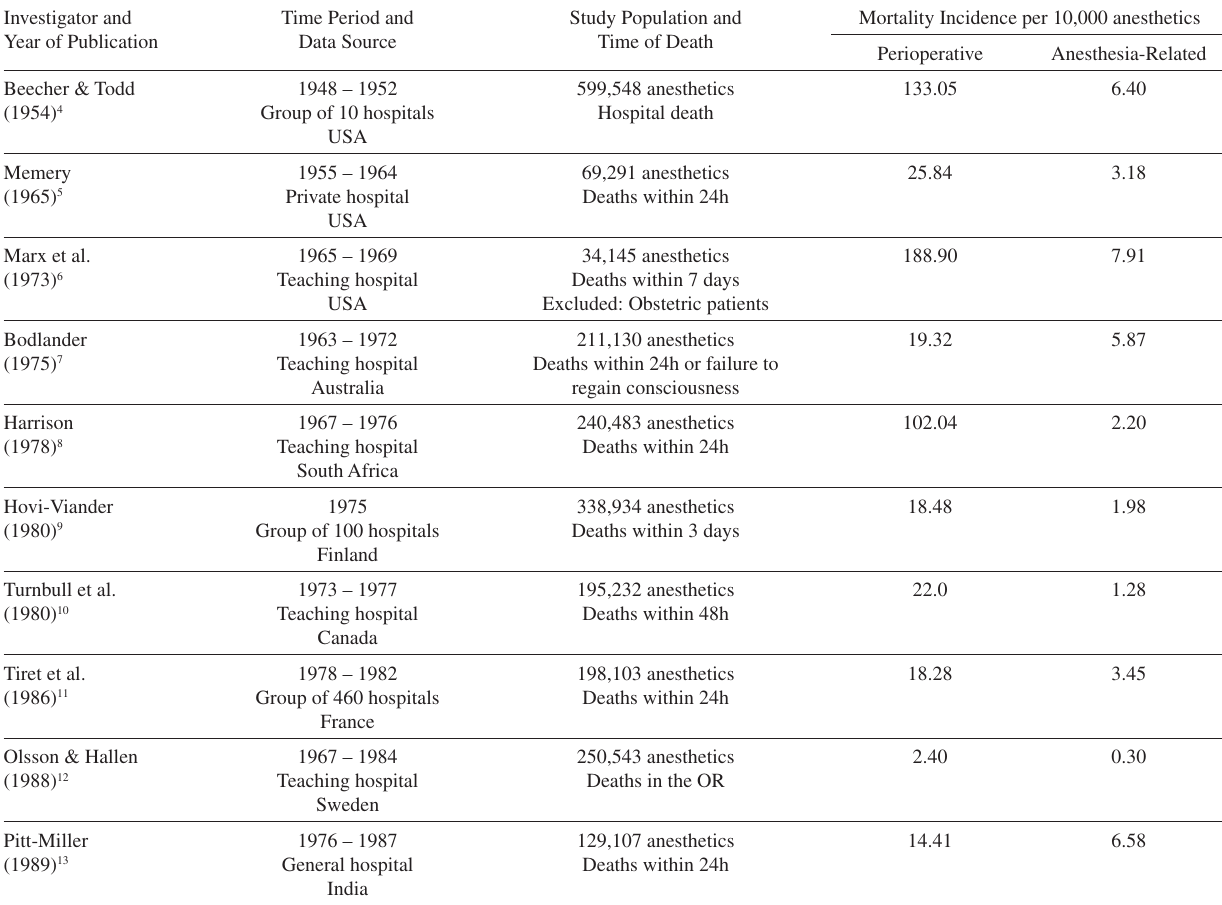
Table 1 - Mortality incidence in patients undergoing anesthesia according to studies performed in different countries